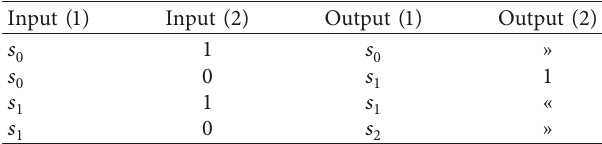
Table 4: An example of a transition function in a universal Turing machine, represented as a look-up table, as described in the text (based on the example in [57, Section 2], with